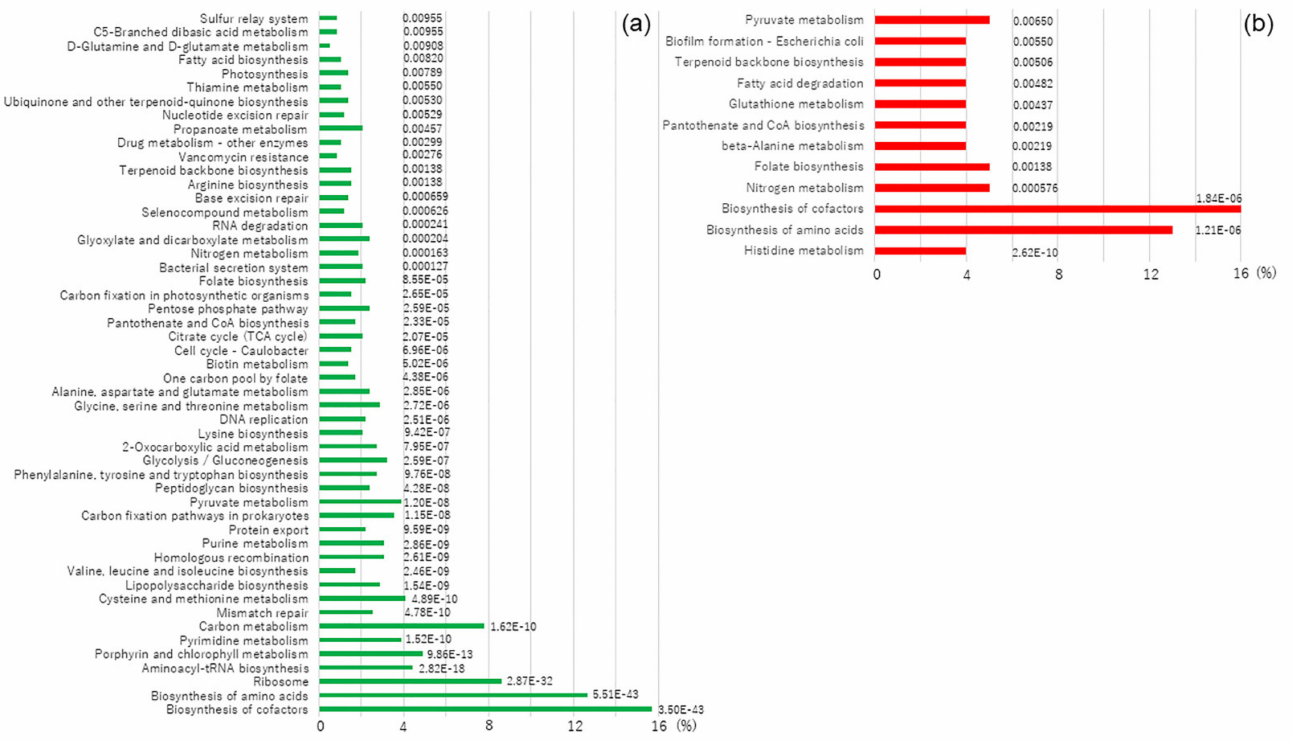
Figure 4. Enrichment results of core and accessory genomes. The enrichment significance was shown as the numerical values next to each bar graph. ( a ) Core genomes using the enrichment analysis. ( b ) Accessory genomes using the enrichment